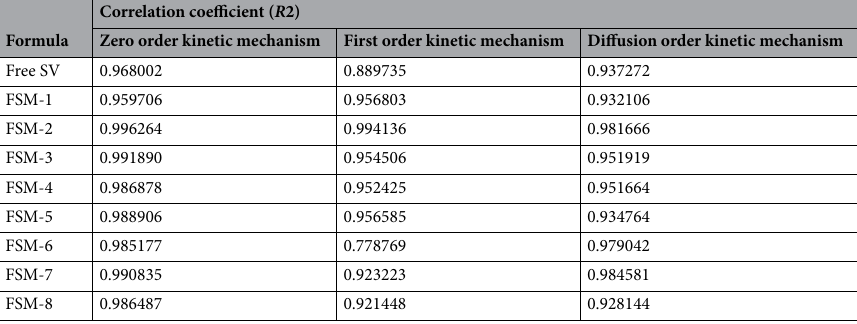
Table 2. Kinetic variables for in-vitro release of SV from different microsponges formulations.